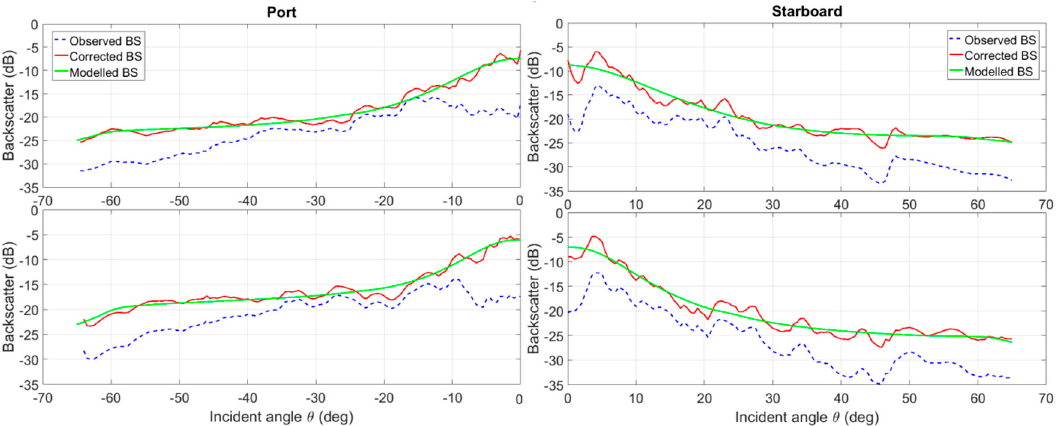
Figure 4. Two typical examples of optimization problem in which three geoacoustic parameters were searched for, Port side ( left ), Starboard side ( right ); indicated in plots are observed backscatter curve (dashed blue line), corrected backscatter curve after applying calibration curve (solid red line), and modeled backscatter curve (solid green line).